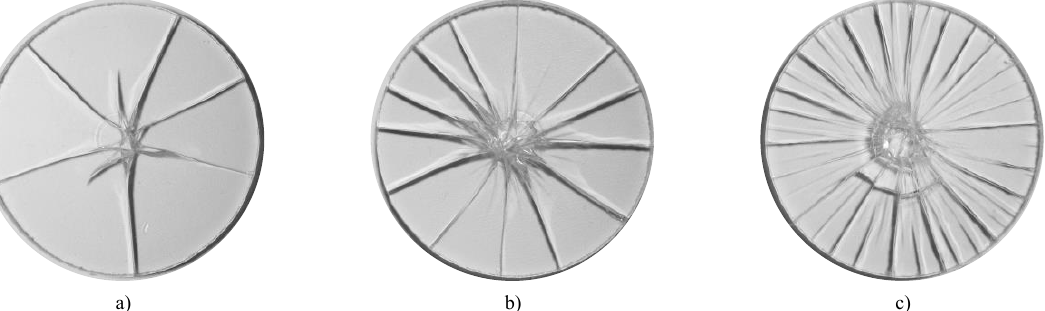
Fig. 8 Representative fracture patterns obtained from the experiments tested with a target piston velocity of 1.7∙10 -3 mm/s (quasi-static loading rate). The determined fracture strengths are a) σ f = 89 MPa, b) σ f = 135 MPa, and c) σ f = 259 MPa. (from Bønding and Meyland